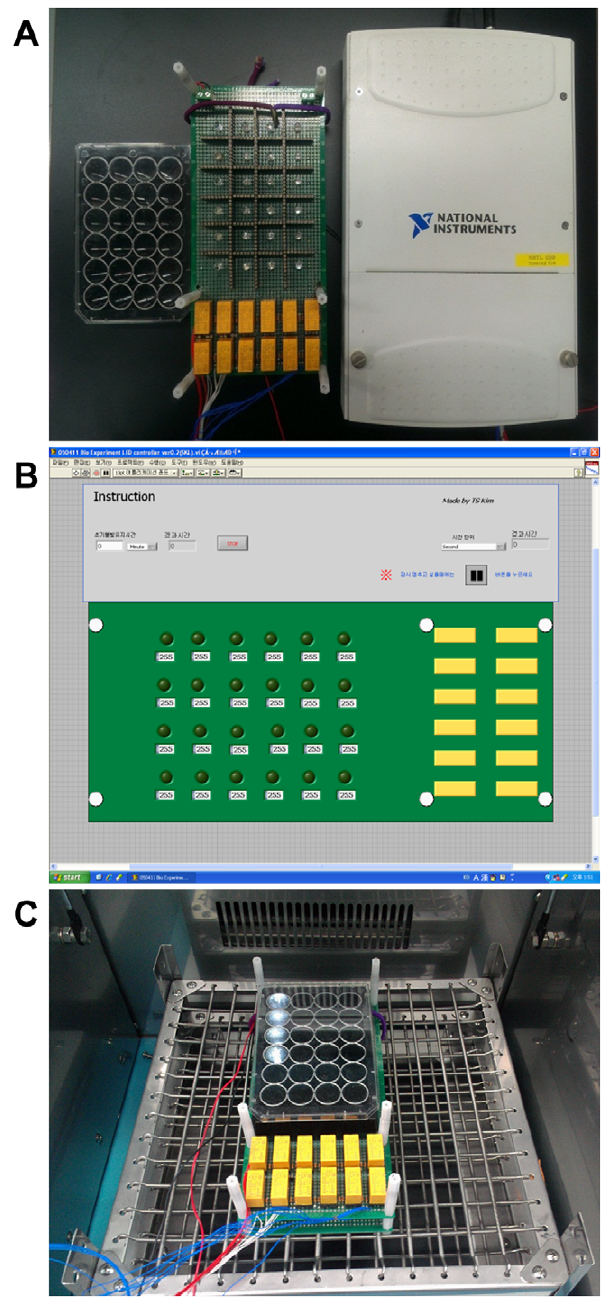
Figure 1. A light-controllable bioreactor system. (A) A home- made electric circuit and a data acquisition system to determine the effect of light duration on gene expression in the bioreactor was combined with a black, commercial 24-well plate. (B) The software interface is shown. Culture conditions in each well, such as the time of exposure to light, were controlled using the software LabVIEW. (C) This figure shows the bioreactor mounted on a rotating orbital shaker placed in an